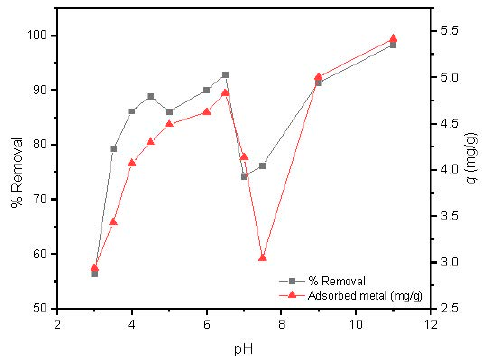
Figure 6. Influence of pH on Cd(II) adsorption by MAAC beads.